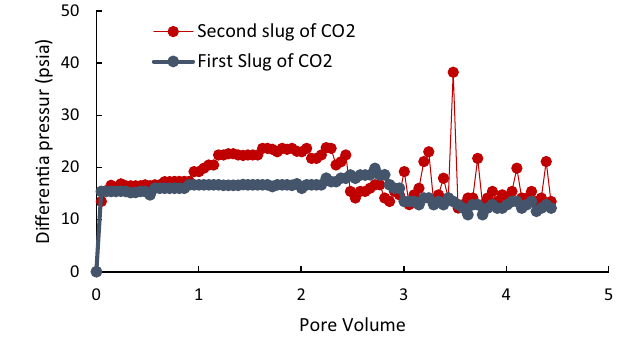
Fig. 6 Performance of injected CO surfactant solution of 0.2%SDS + 0.2%TX100